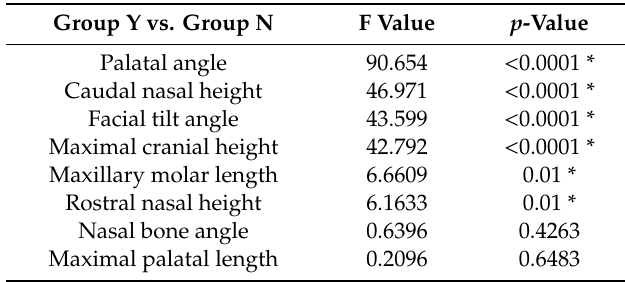
Table 3. MANOVA results of the linear morphometric data.